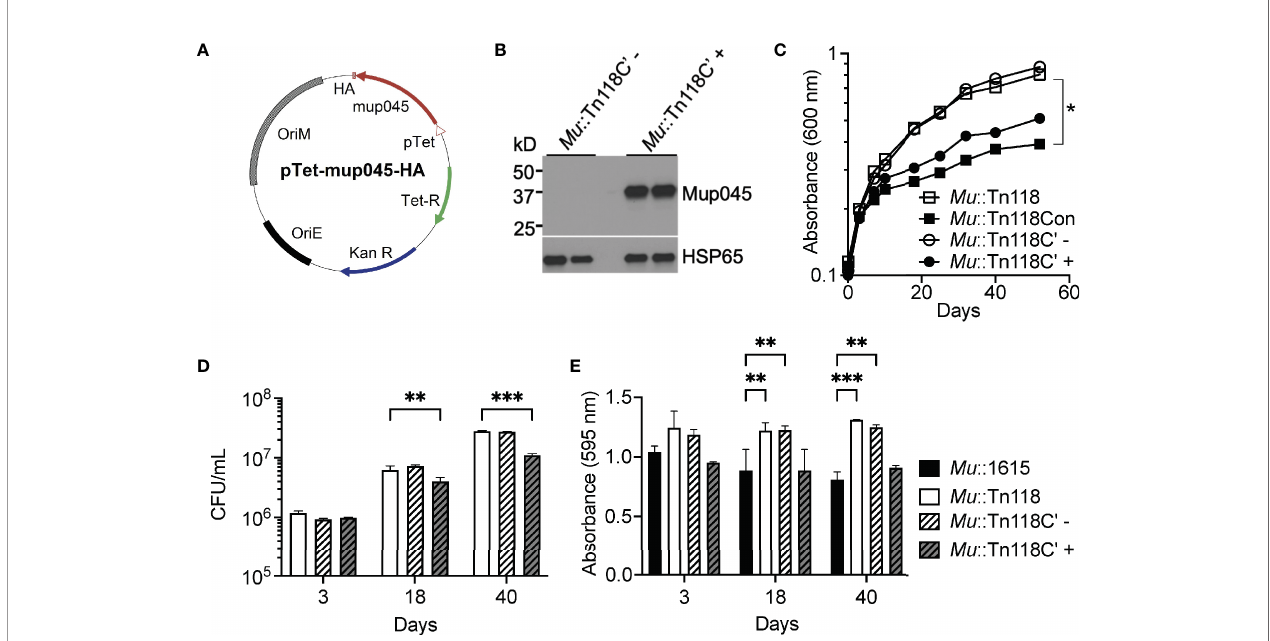
FIGURE 4 | Expression of the mycolactone accessory gene ( mup045 ) inhibits bacterial growth and restores mycolactone production in Mu ::Tn118. (A) Plasmid map for pTetR- mup045 is shown. Expression of mup045 (blue) C-terminally tagged with HA is driven by the tetracycline promoter (pink). (B) Con fi rmation of expression of HA-tagged mup045 in Mu ::Tn118 under the tetracycline-inducible promoter ( Mu ::Tn118C ′ ) with (+) and without (-) 1 m g/ml anhydrous tetracycline (aTCN) at day 25 growth in 7H9. (C) Growth curve of recombinant Mu ::Tn118 in 7H9 constitutively expressing mup045 ( Mu ::Tn118Con) or expressing mup045 under the aTCN- inducible promoter ( Mu ::Tn118C ′ ) ± 1 m g/ml aTCN. (D) Correlating CFU from growth curves at days 3, 18, and 40 of growth in 7H9. (E) Cytotoxicity of mycolactone extracted from 7H9 cultures at days 3, 18, and 40 as determined by MTT assay in L929 cells. All graphs represent one of three independent experiments with data expressed as mean ± SD. Signi fi cance was calculated by two-way ANOVA corrected by Dunnett ’ s test for multiple comparisons. *p ≤ 0.05, **p ≤ 0.01, *** ≤ p